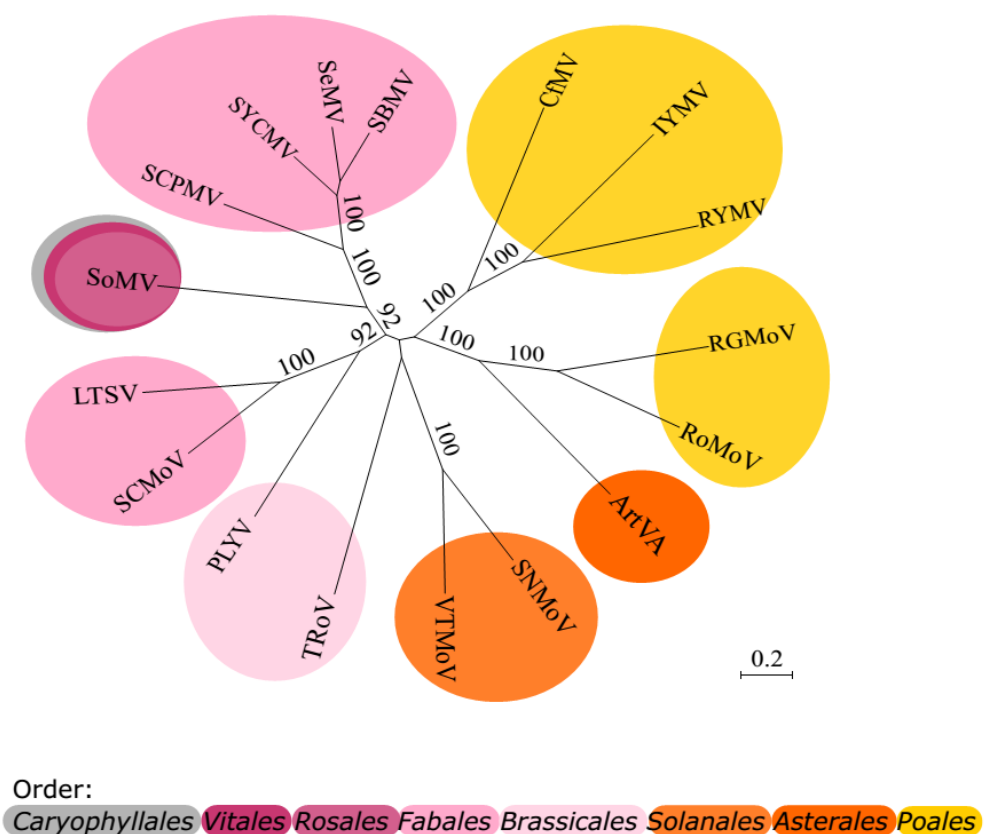
Figure 4. Unrooted maximum-likelihood tree of the complete sobemovirus genome sequences. The tree was generated with the Seaview 4.4.2 program using the GTR nucleotide substitution model [219]. Numbers at the branches indicate bootstrap values (only the scores exceeding 70% are shown). The support of the nodes was assessed after 1000 bootstrap replicates. The scale bar represents the number of nucleotide substitutions per site. Affiliation of the host species to the higher taxonomy units: core eudicots (grey), rosids (pink), asterids (orange), and commelinids (yellow). A mean mutation rate of RYMV genome has been calculated to be 5.2 × 10 −4 nt/sites per year.